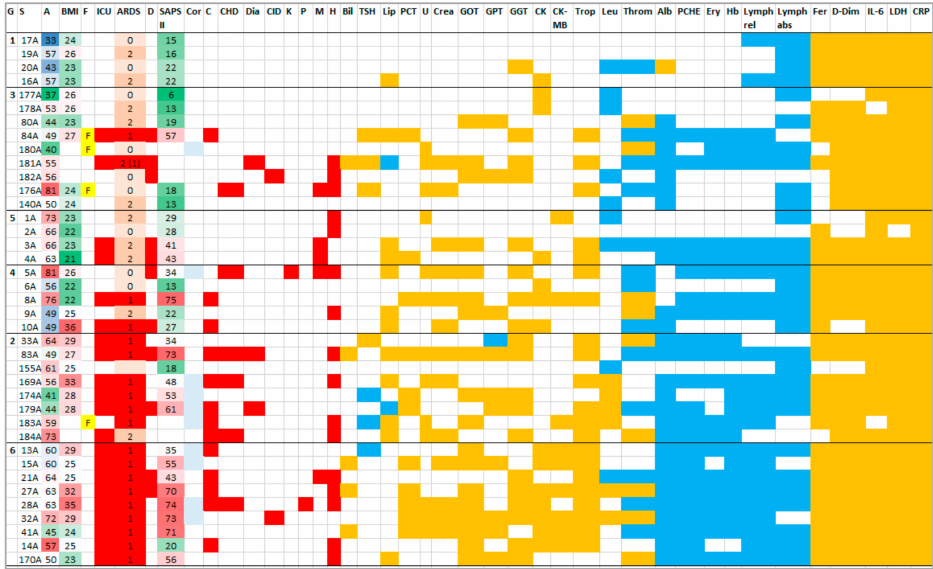
Figure 4. Visual matrix of patient data and clinical parameters (for details, see [2]). G, group; S, sample; A, age; BMI, body mass index; F, female; ICU, intensive care unit; ARDS (1), disease severity (0-no O 2 , 2- with O 2 ); D, death; Cor, cortisone treatment; C, coinfection; CHD, coronary heart disease; Dia, diabetes; CID, chronic inflammatory disease; K, kidney disease; P, pulmonary disease; M, malignome; H, arterial hypertonia; Bil, bilirubin; Lip, lipase; U, urea; Crea, creatinine; Trop, troponin; Leu, leucocytes, Throm, thrombocytes; Alb, albumin; Ery, erythrocytes; Lymph, lymphocytes relative/absolute; Fer, ferritin; D-Dim, D-dimers. Orange—values higher than normal, blue—values lower than normal. Red—presence of co-morbidity and a general marker for death, ICU, high BMI and old age. Light blue—cortisone treatment. Green-to-red scale for SAPS II, BMI and